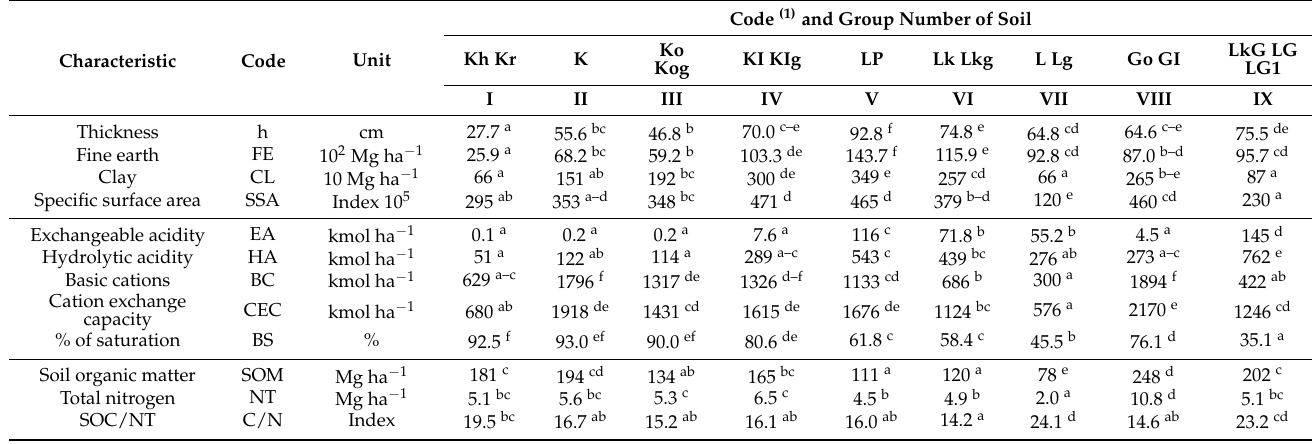
Table 1. Properties of research areas ( n = 147) of soil cover or solum.